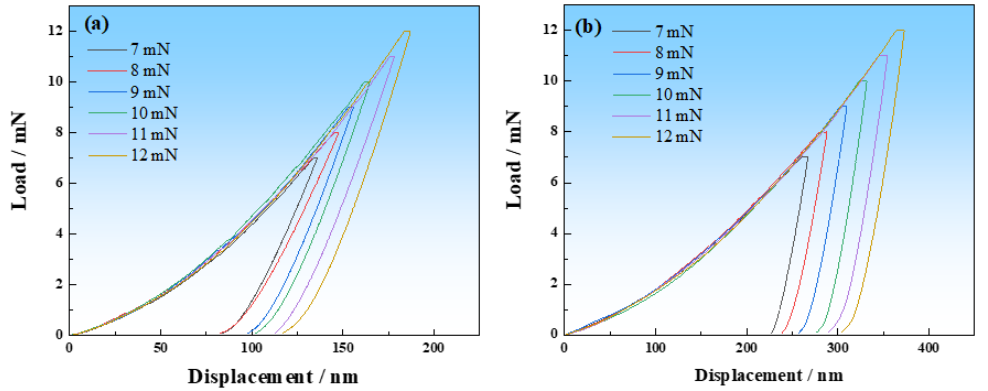
Figure 6. Load–displacement curves of the ( a ) σ -phase and ( b ) austenitic matrix, in which six nano-indentation loads from 7 mN to 12 mN were applied.